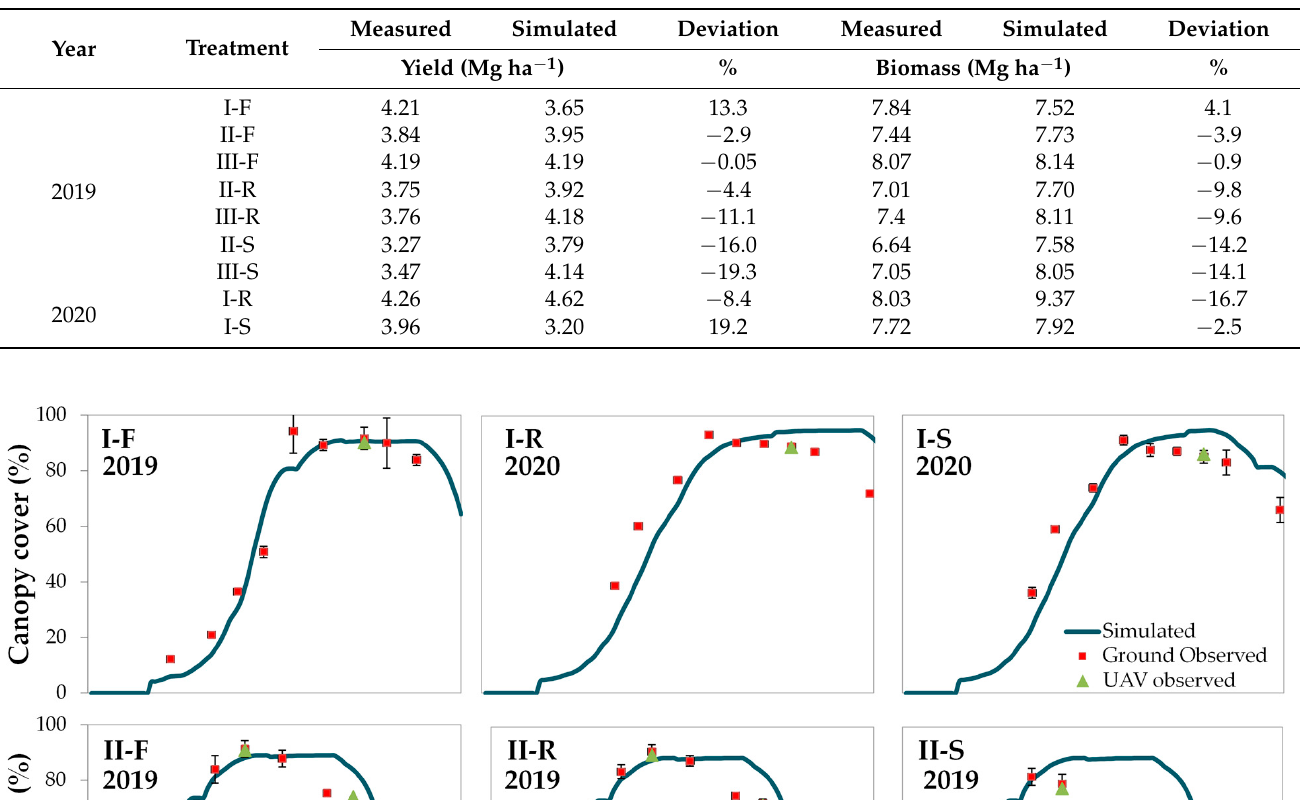
Table 6. Measured vs. simulated results for validation datasets of common bean grown under different water treatments; full (F) and deficit (R and S) irrigation and sowing period conditions I (spring), II (late spring), and III (summer).